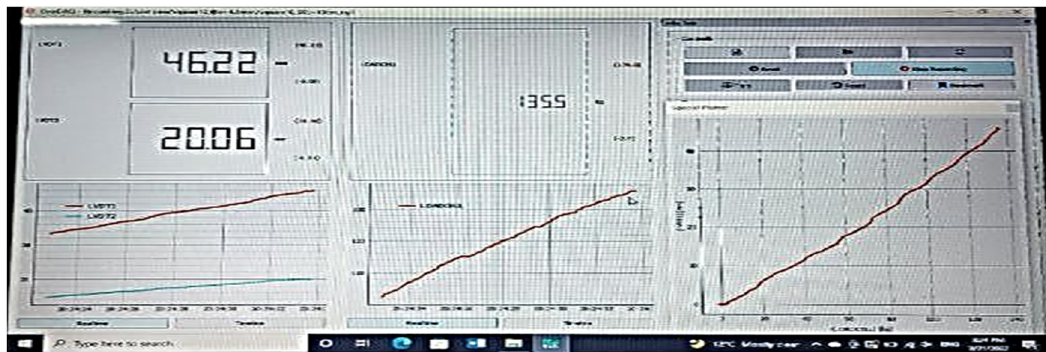
Figure 7: One D.A.Q. Graphical interface. Al - KHAIRO developed it.